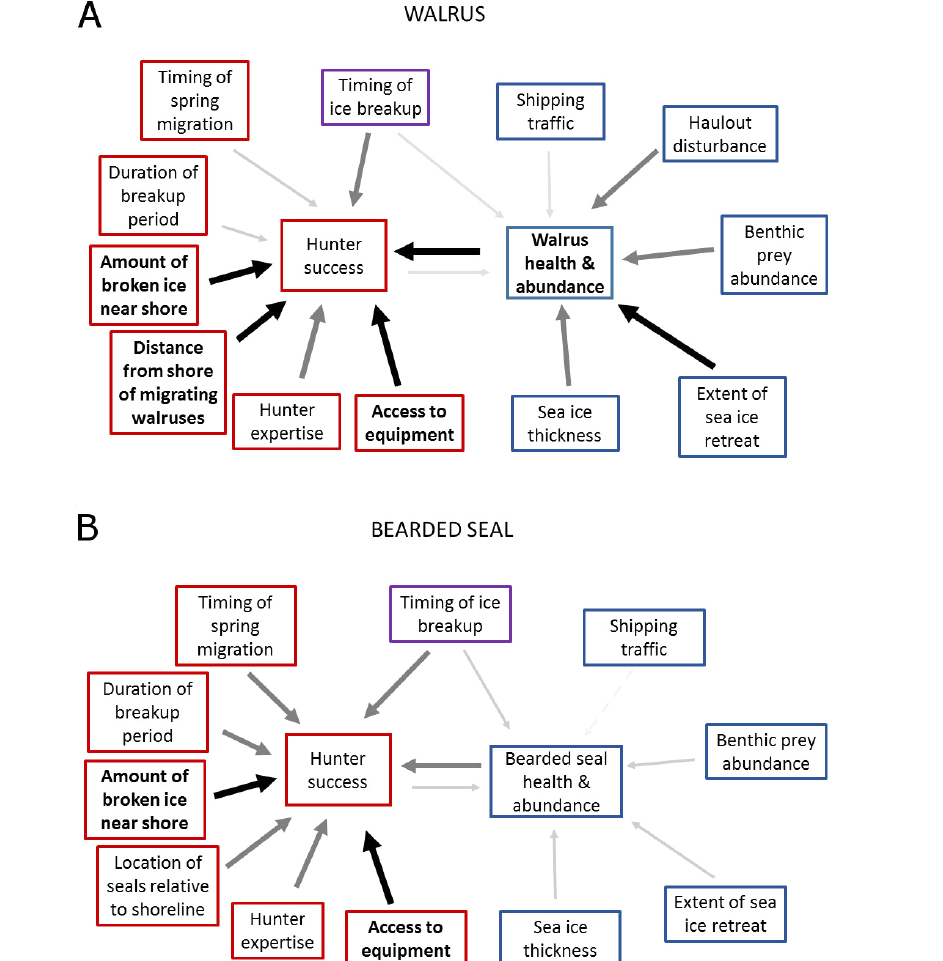
Fig. 4 . Factors influencing hunter success (outlined in red) and health and abundance (outlined in blue) of (A) walruses ( Odobenus rosmarus ) and (B) bearded seals ( Erignathus barbatus ) identified in workshops in Wainwright, Alaska. The darkness of arrows indicates the proportion of people who considered each factor as “very important.” Factors that were considered “very important” by > 80% of respondents are in bold. See Appendix 2 for a full table of results. Data were collected during workshops 3 and 4 by 8